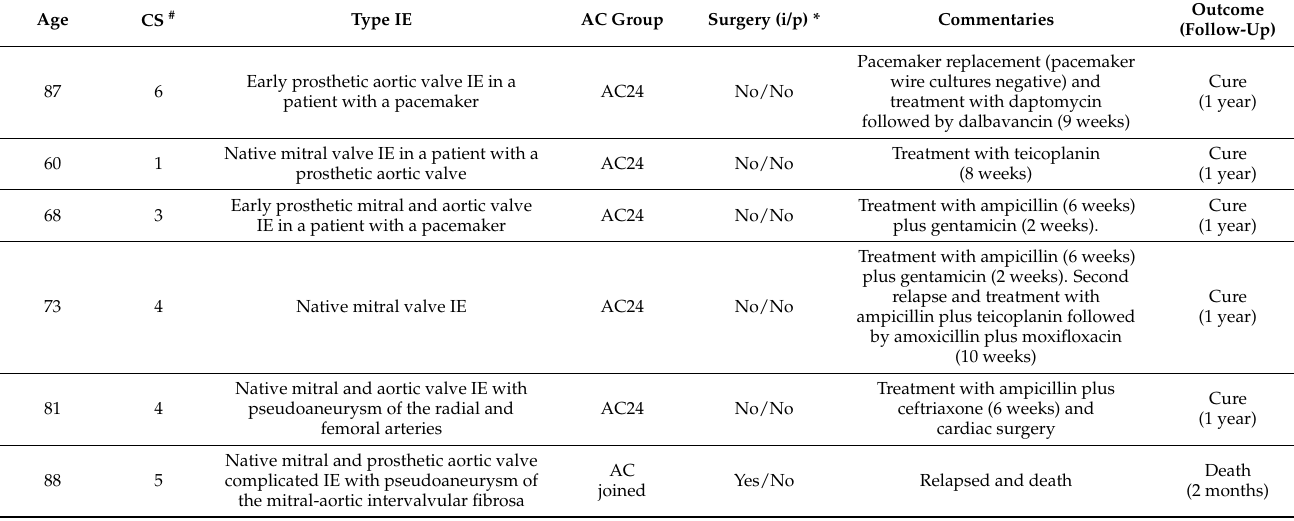
Table 3. Description of relapsed